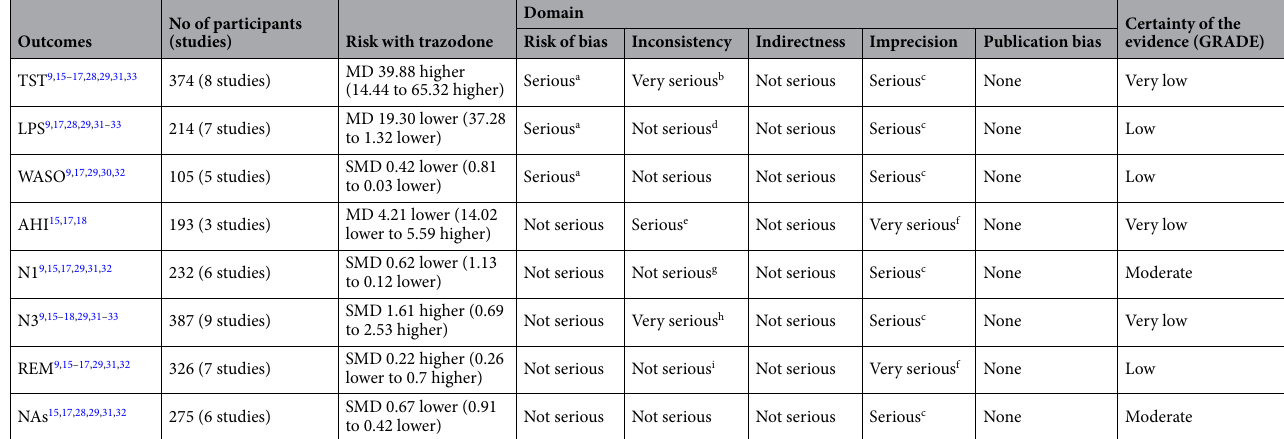
Table 7. Study quality of evidence according to GRADE guideline. GRADE Grading of recommendations assessment, development and evaluation, MD Mean difference, SMD standardized mean difference, TST Total sleep time, LPS latency to onset of persistent sleep, WASO wakefulness after persistent sleep onset, AHI Apnea–hypopnea index, N1 non-rapid eye movement stage 1, N3 non-rapid eye movement stage 3, NAs the number of awakenings, REM Rapid eye movement sleep. a According to Revised Cochrane risk-of-bias tool for randomized trials (RoB 2), most studies included in this meta-analysis were evaluated to have significant risk of bias concerns. b Significant unexplained heterogeneity (I 2 = 82%). c Serious imprecision due to the small sample size (< 400 participants). d Significant heterogeneity (I 2 = 97%) can be explained by sensitive and subgroup analysis. e Moderate unexplained heterogeneity (I 2 = 57%). f Very serious imprecision due to the small sample size (< 400 participants) and wide confidence interval. g Moderate heterogeneity (I 2 = 62%) can be explained by sensitivity analysis. h Significant unexplained heterogeneity (I 2 = 93%). i Moderate heterogeneity (I 2 = 73%) can be explained by sensitivity